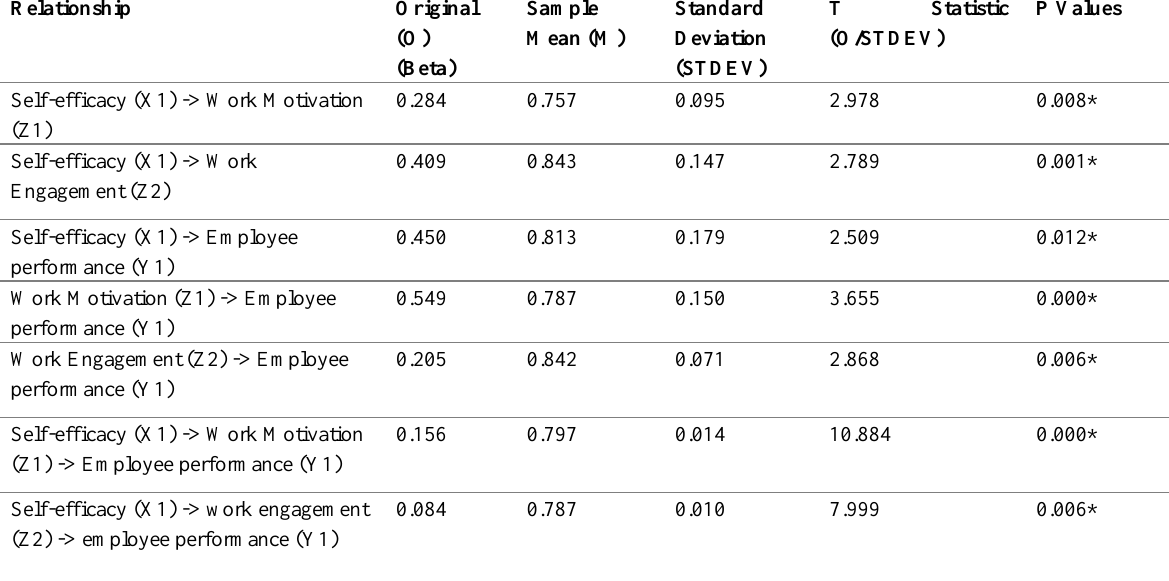
Table 5: Hypothesis Test (Partial and Mediation)